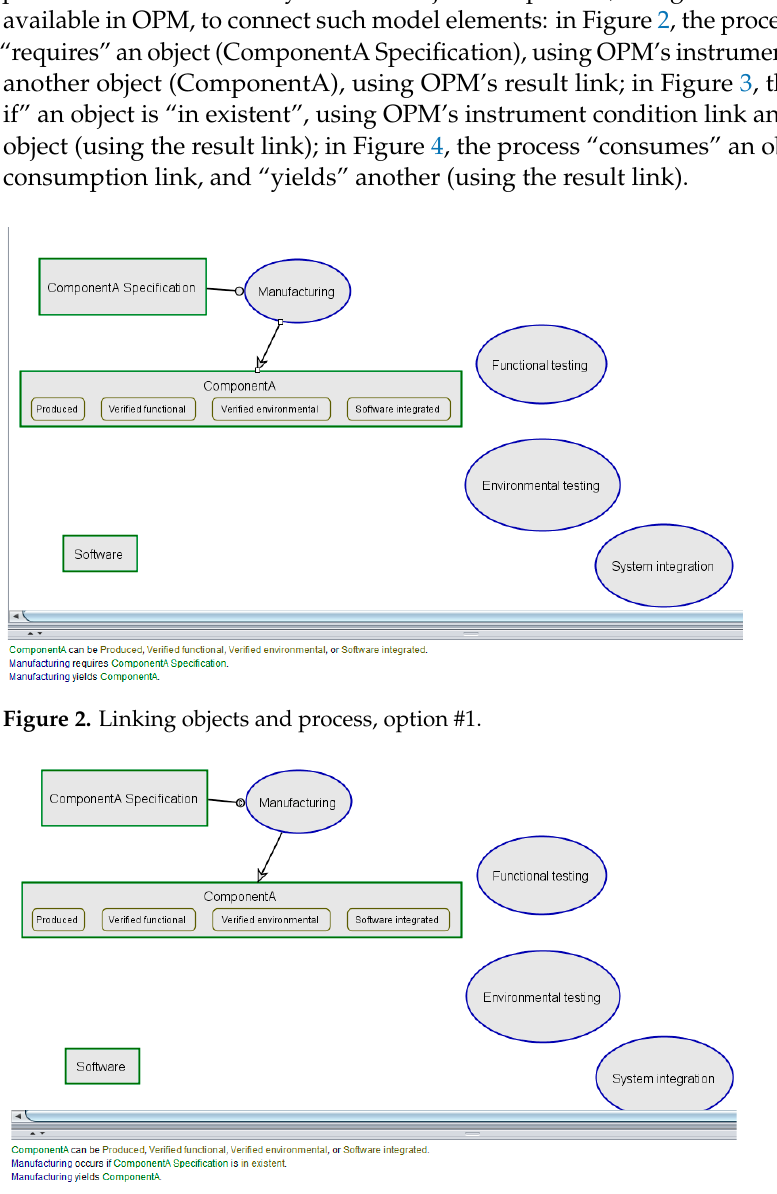
Figure 4. Linking objects and process, option #3.